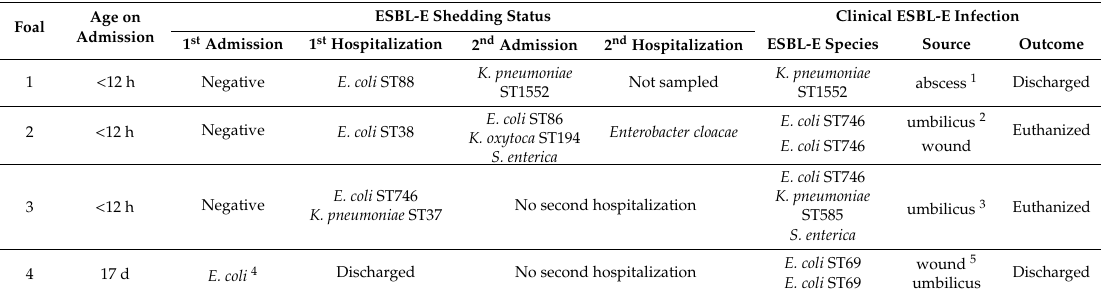
Table 3. ESBL-E from clinical and samples isolated from four foals during